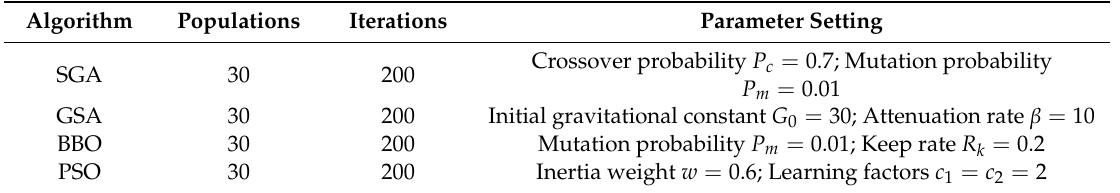
Table 2. Algorithm parameters for the parameter estimation of HTRS.